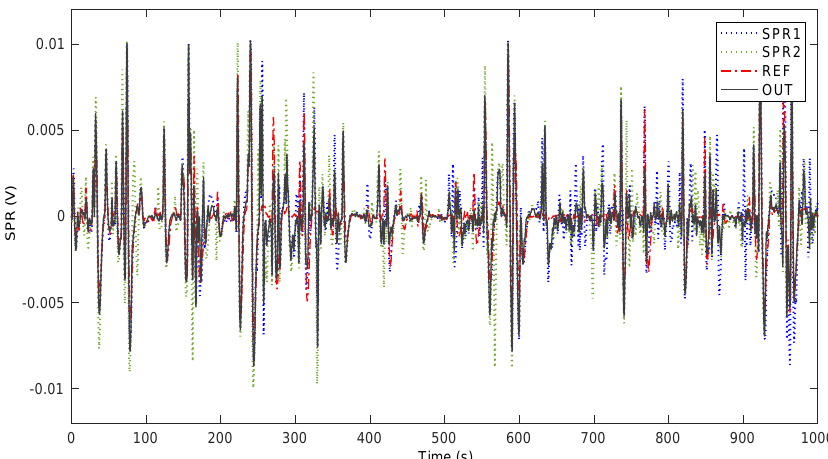
Figure 3. Comparison of the signals acquired from the two hands, the reference signal and the output of the proposed algorithm in the Motion Artifact (MA) test.